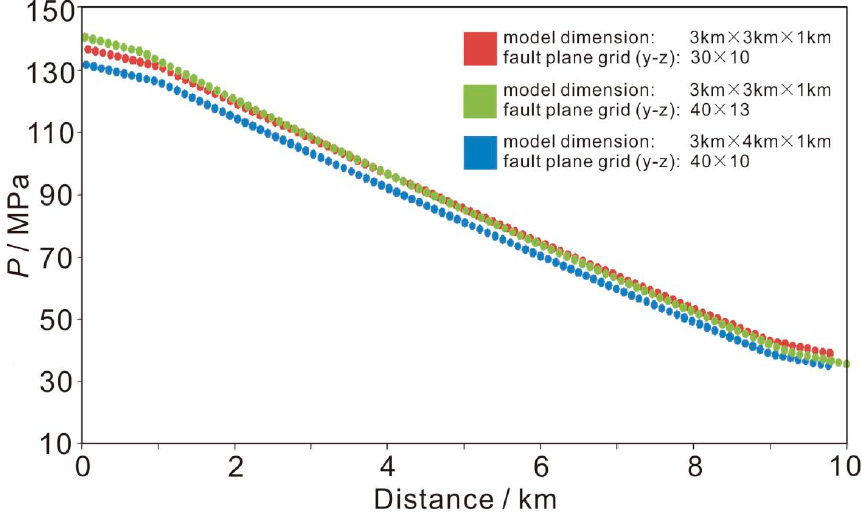
Figure 9. Pore pressure along the dip from the intrusion point in the fault plane for varied model and grid dimensions.